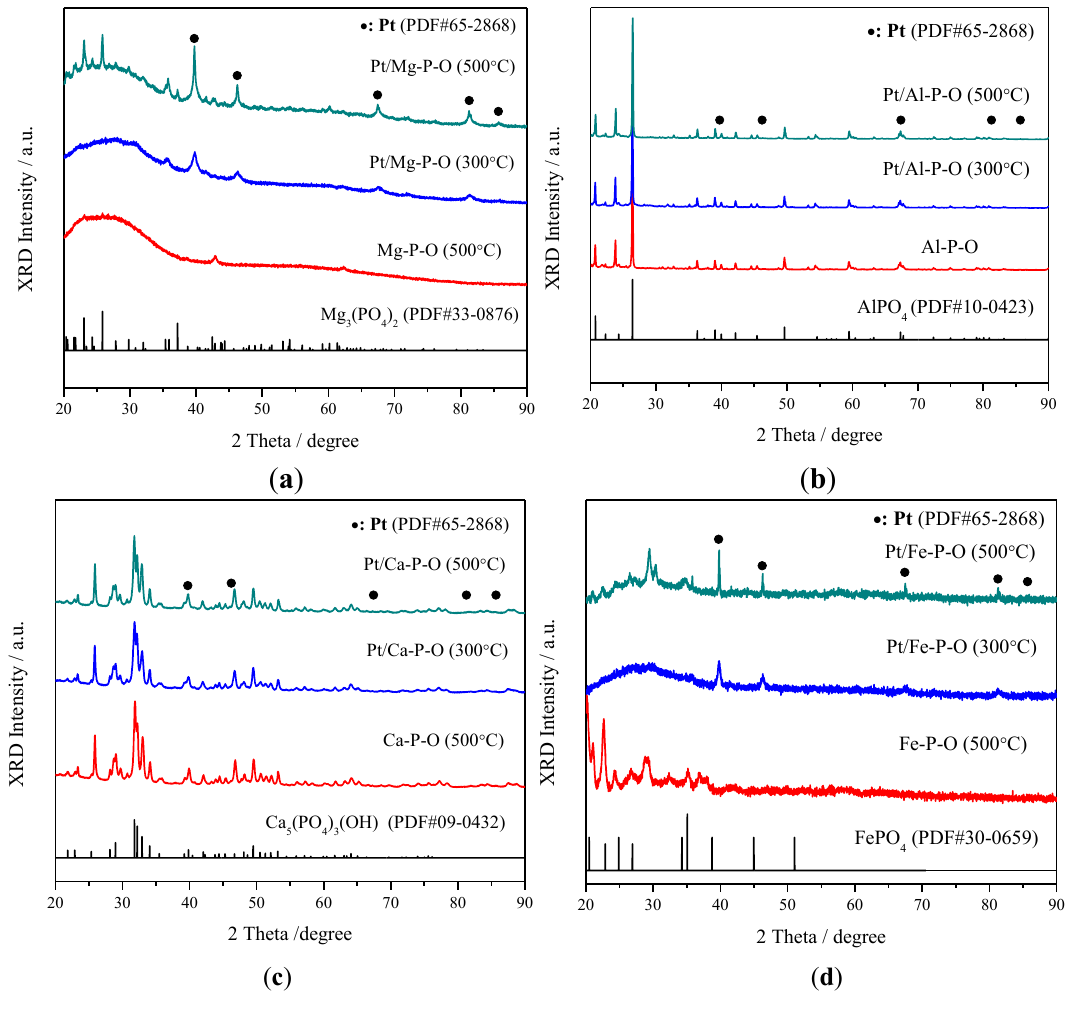
Figure 2. XRD patterns of spent Pt/M-P-O catalysts (calcined at 300 or 500 °C,